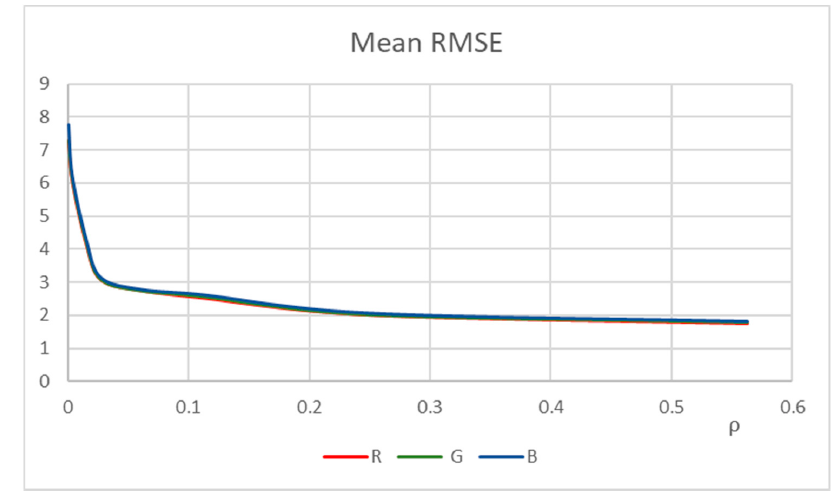
Figure 13. Mean RMSE trend in the three band.